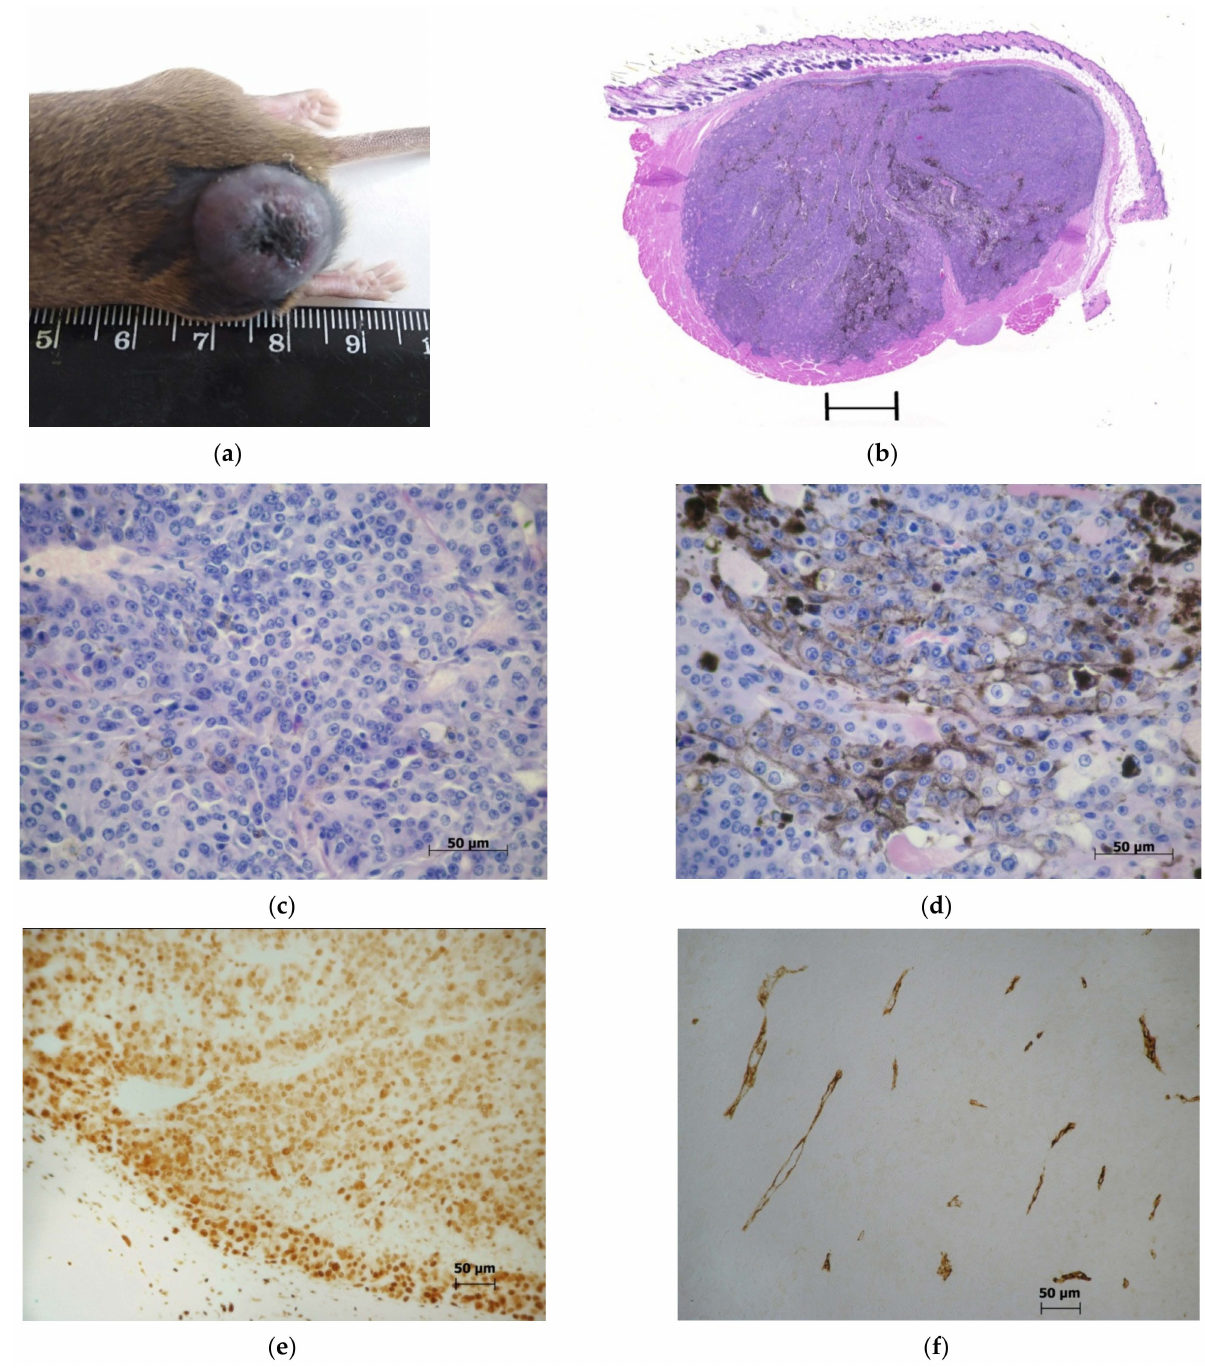
Figure 2. The morphology pattern of the B16 melanoma in the controls (control 1 and control 2) on the 30th day after the transplantation: ( a ) the macrophoto of the B16 melanoma on the 30th day after implantation under the skin of the thigh; ( b ) The histological pattern of the B16 melanoma on the 30th day after implantation. Staining with hematoxylin and eosin. Scan; ( c ) The histostructure of the B16 melanoma in the zone of solid growth. Staining with hematoxylin and eosin. × 40; ( d ) The melanin-containing cells in the tumor parenchyma. Staining with hematoxylin and eosin. × 40; ( e ) The PCNA-positive nuclei of the B16 melanoma in the peripheral zone of the tumor. Immunohis- tochemical staining for PCNA. × 20; ( f ) The vascular network in the solid zone of the B16 melanoma. Immunohistochemical staining for CD31; ×